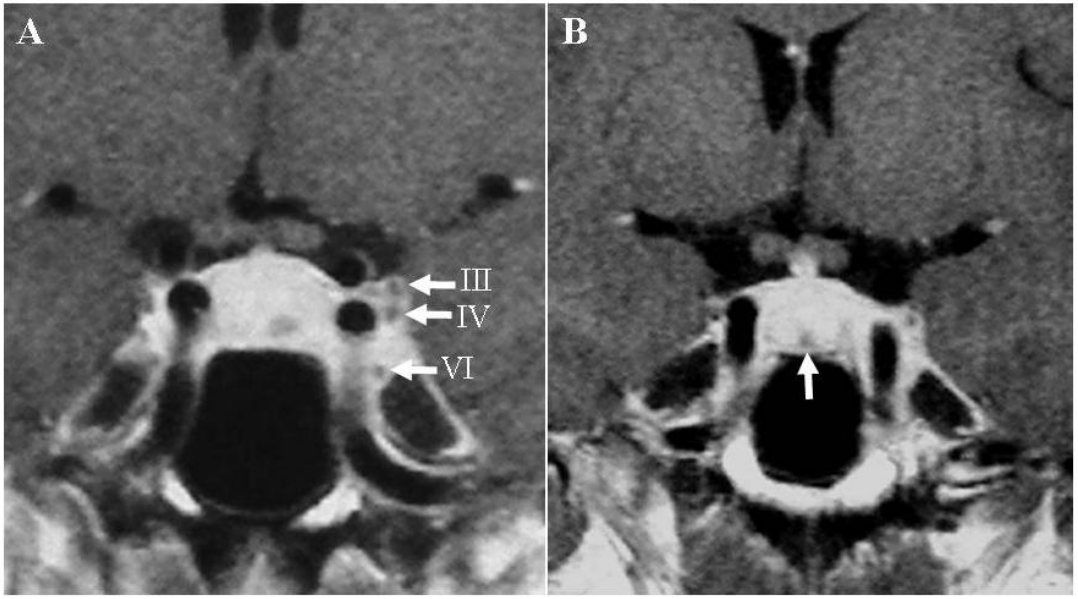
FIGURE 1. Coronal FSE T1-weighted imaging after Gd-DTPA administration MRI of the head. (A) Strong enhancement of the inflammatory tissue inside hypophysis and left cavernous sinus. The third, fourth, and sixth cranial nerves inside cavernous sinus (arrows) appear hypointense. (B) The pituitary focus also appears relatively hypointense